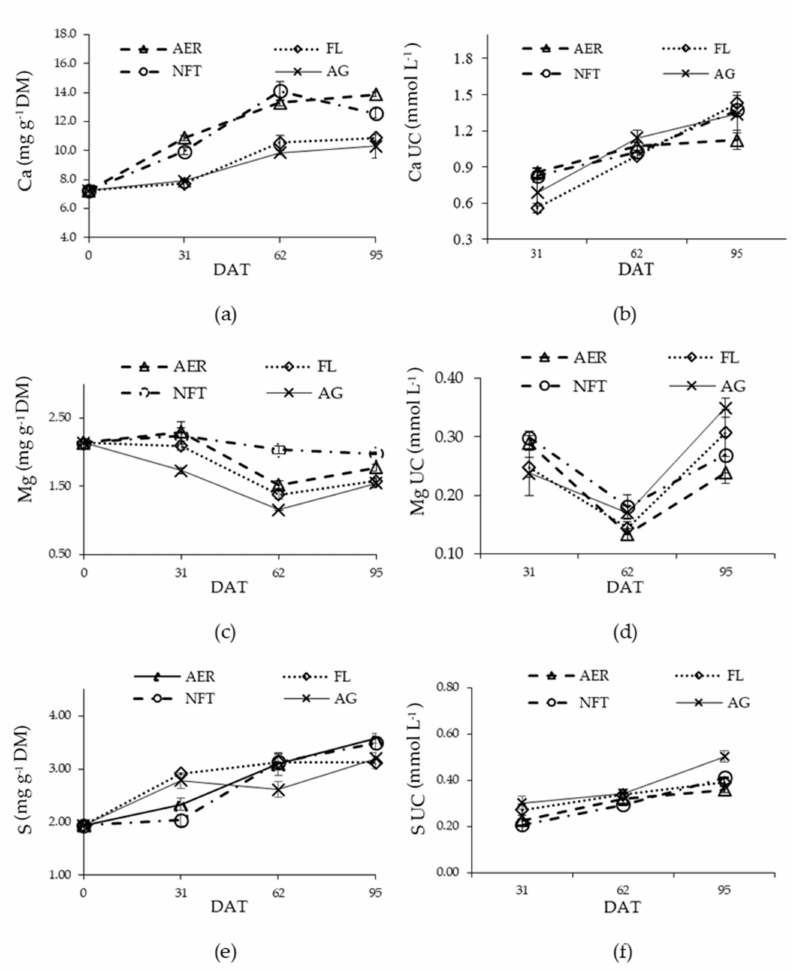
Figure 8. Impact of the different CSCS on the concentrations in the plant dry mass (DM) and on the corresponding apparent uptake concentrations (UC), i.e., mmol of the element uptake per L of water uptake of Ca, Mg, and S. Vertical bars indicate ± standard errors of means of twelve (12) samples per